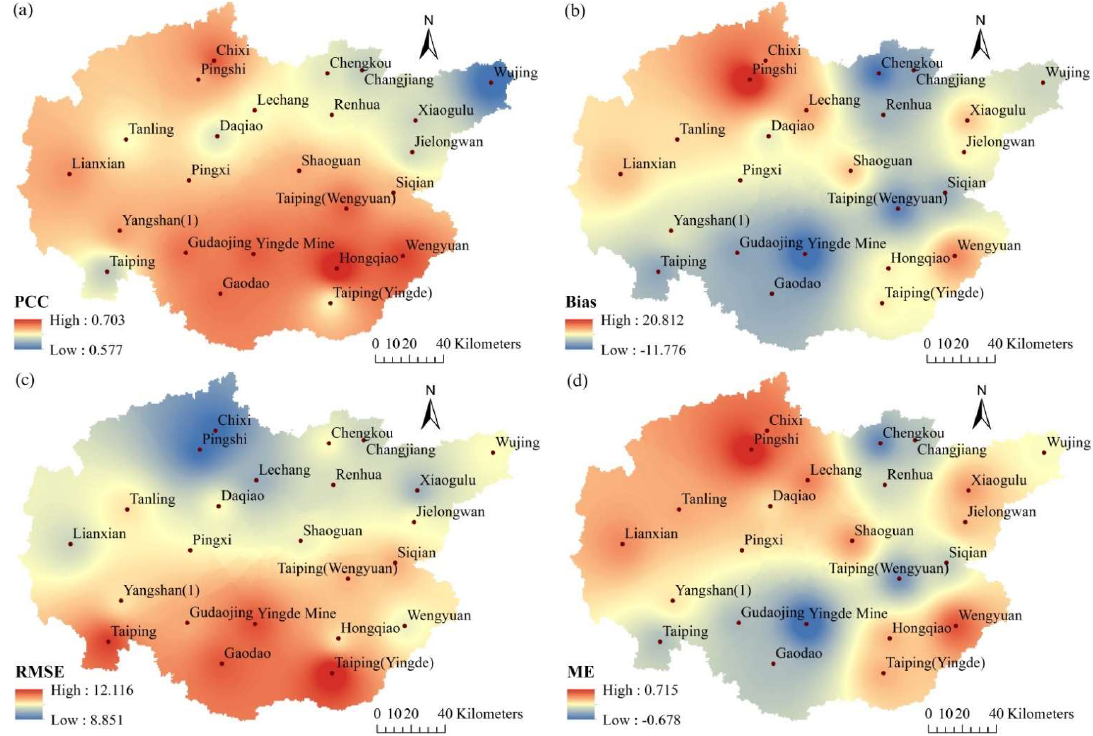
Figure 2. Spatial distributions of the four detected statistical indices: ( a ) POD; ( b ) FAR; ( c ) ACC; and ( d ) FBI.